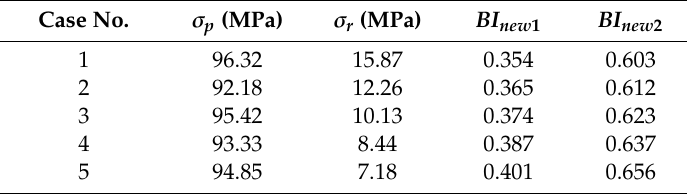
Table 7. Strength parameters and brittleness indexes of five cases of di ff erent size gradations. Case